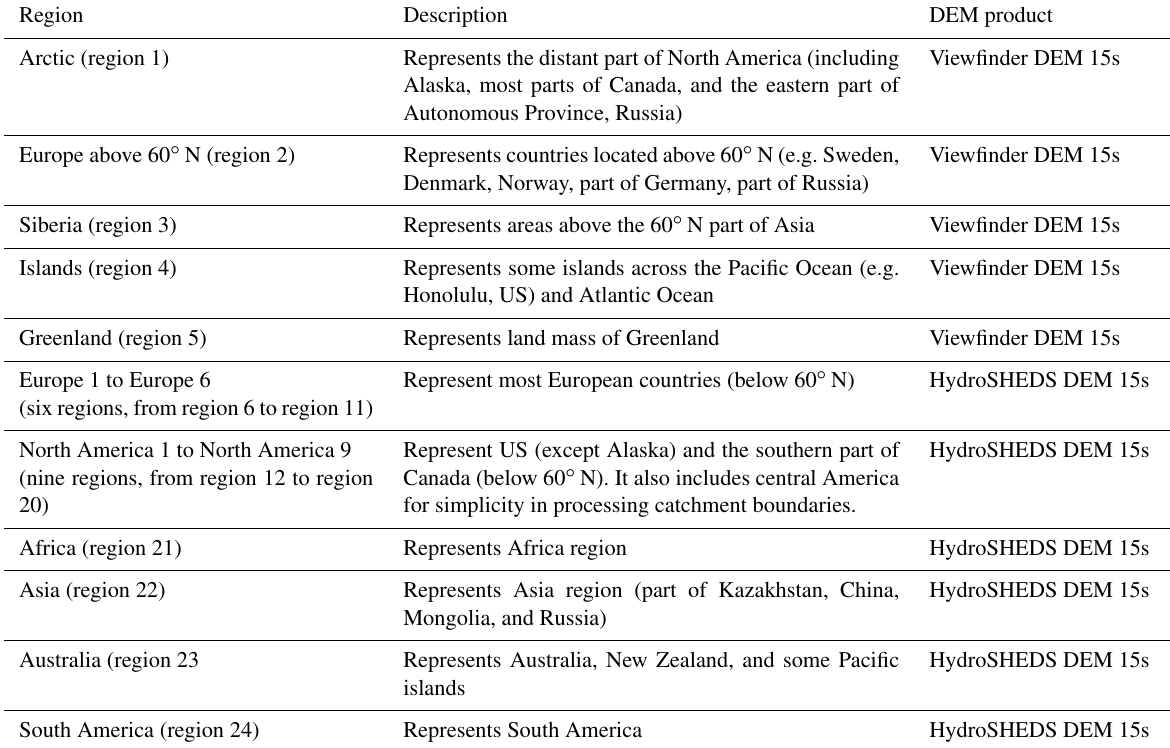
Table 4. DEM products used for each GSIM